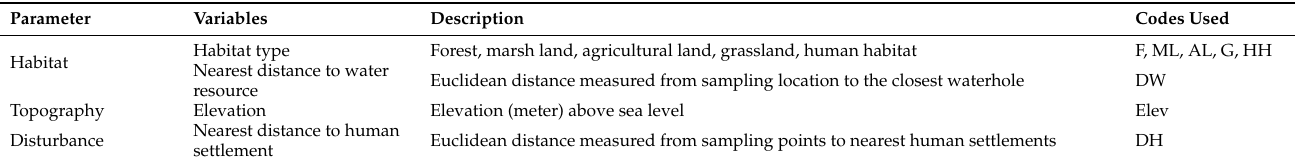
Table 1. Environmental variables recorded in the field and their description.